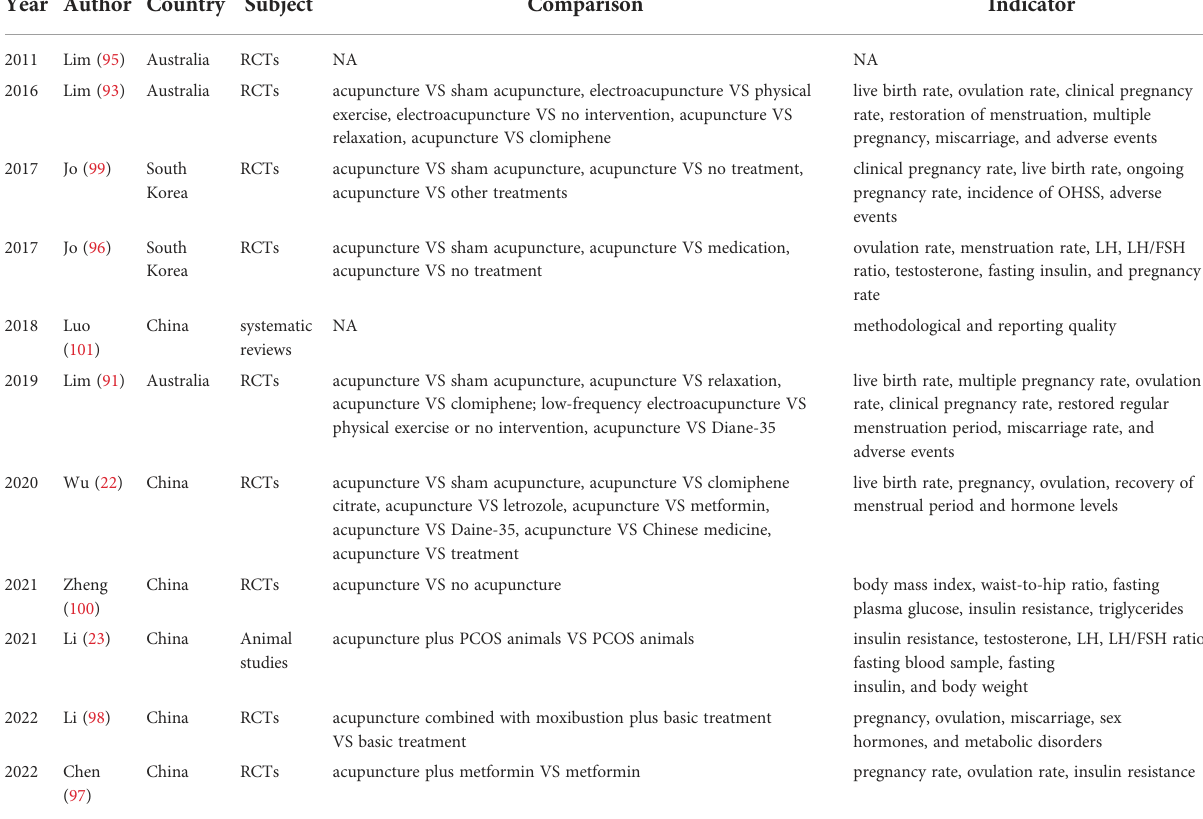
TABLE 2 Characteristics of systematic reviews and meta-analyses assessing acupuncture for